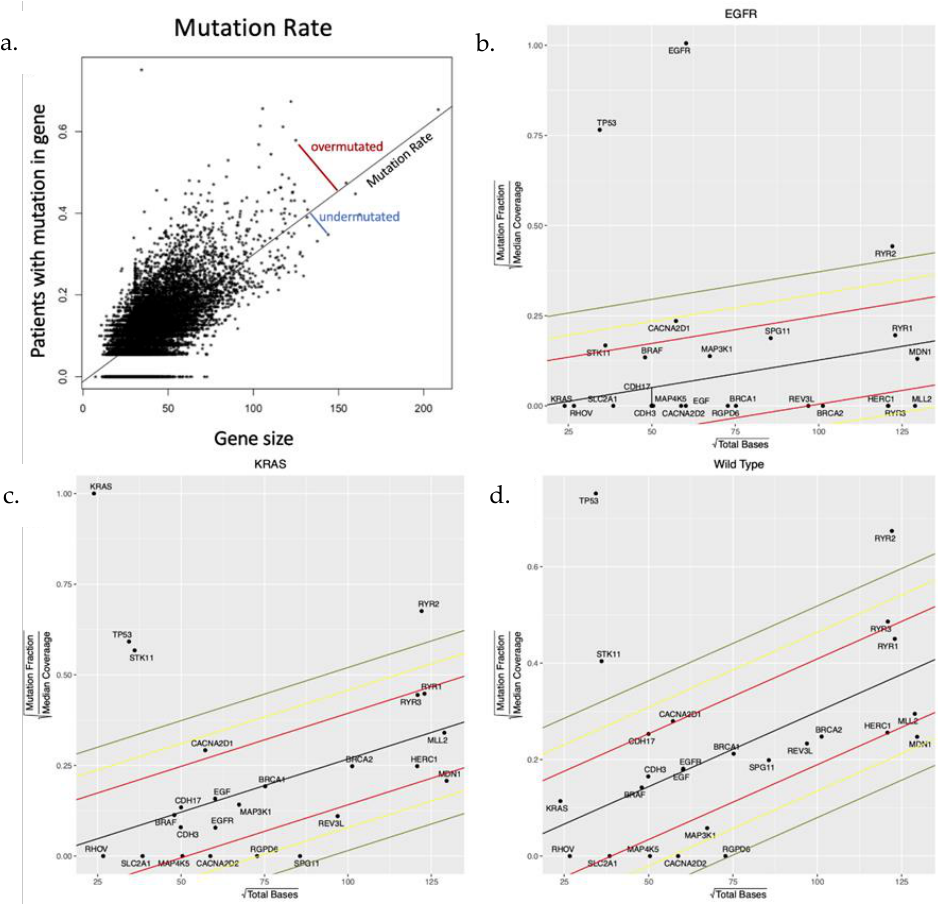
Figure 1. ( a ) A toy model demonstrating the methodology applied to the TCGA data set to identify genes that are observed to be mutated more or less frequently than expected by chance alone. ( b – d ) Simple regression of number of mutations observed in each gene compared to gene size (number of base pairs) produced a “neutral line” reflecting the number of genes mutated due to chance alone depending on the underlying mutation rate and gene size. The slope of the line in each cohort reflects the mutation rate which is smallest in the EGFR-mut cohort and largest in the NEK cohort. In each cohort, the genes of interest that are under evolutionary selection are shown.